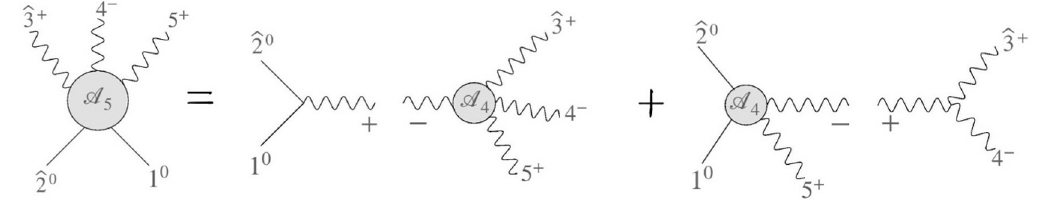
Figure 3 . Five-particle amplitude in scalar